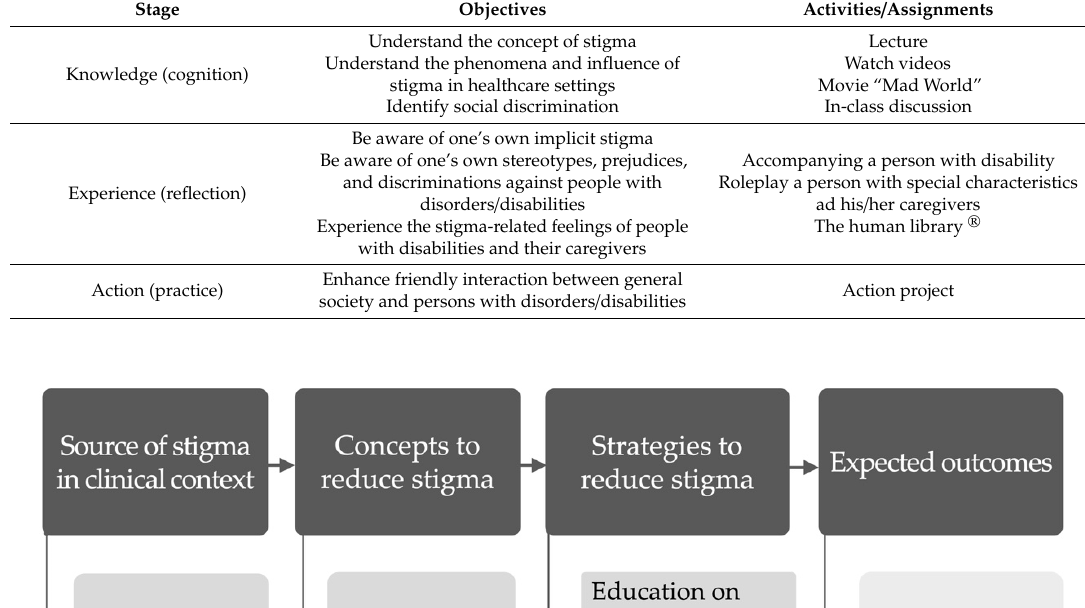
Table 1. Course framework.